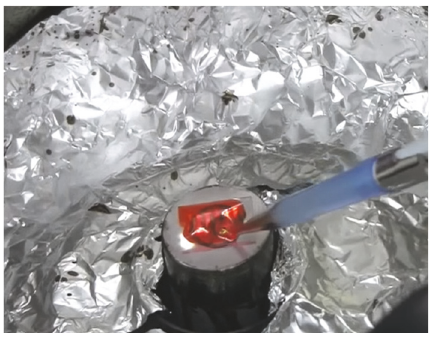
Figure 3: P3HT: PCBM (1 :1) spin coating.